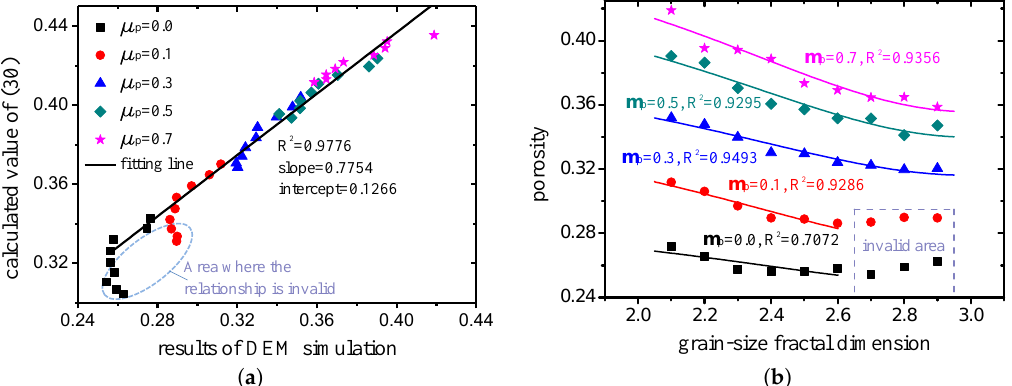
Figure 8. ( a ) Comparison of porosity measured from DEM simulation with values calculated by (30); ( b ) porosity of grain-size fractal granular media with different fractal dimensions and friction coefficients (the scattered points represent the results of the DEM simulation, while the solid lines represent the results calculated by (30)).